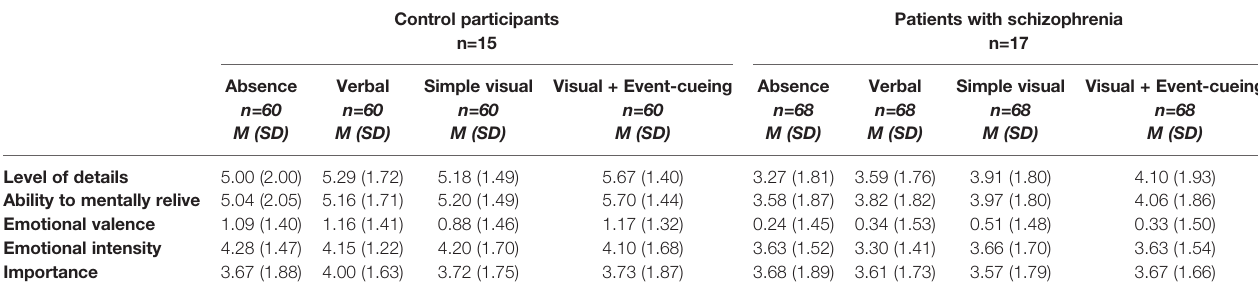
TABLE 4 | Means (M) and standard deviations (SD) of memories characteristics subjectively evaluated by participants during the recognition task. Control